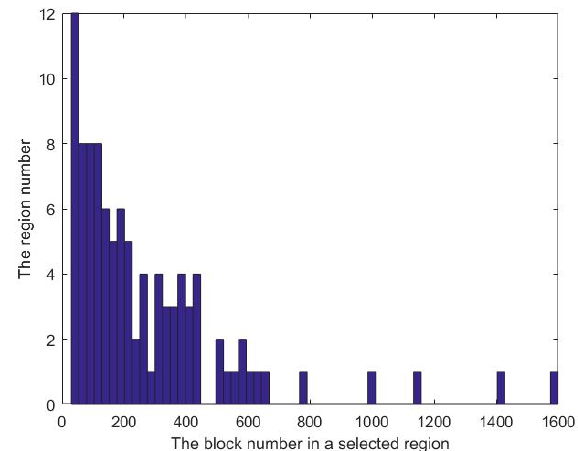
Figure 7. The histogram of the block number in the protected regions.